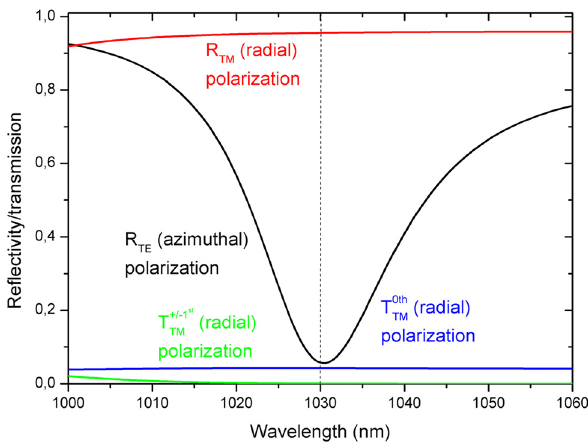
Figure 10: Calculated reflectivities (0th order) for TE and TM polarized radiation and transmissivities (0th and ± 1st orders) for TM polarized radiation incident on the GWOC with the new